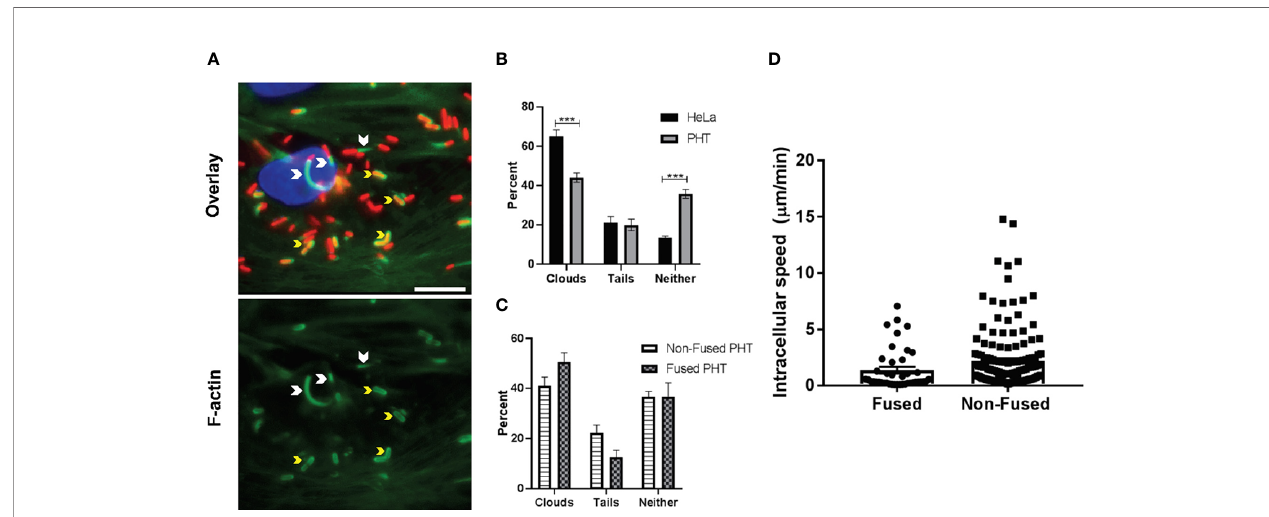
FIGURE 4 | Measure of F-actin clouds and comet tails. PHT and HeLa cells were infected with p actA -RFP L. monocytogenes for a total of 5 h (MOI 1). Cells were fi xed and labeled with DAPI, phalloidin-Alexa Fluor 488, and anti-E-cadherin antibodies conjugated to Alexa Fluor 647 (PHT only). Fluorescence images were acquired with the 100X objective and analyzed for the presence of F-actin comet tails and clouds. (A) Representative images, arrowheads point out F-actin tails and yellow arrows depict F-actin clouds. Scale bar = 50 µm. (B, C) At least 190 bacteria were counted per experimental condition in each experiment. Data are presented as Average percentages ± SEM (n = 3 (3 placentas), each experiment performed in duplicate). Statistical signi fi cance was determined by two-way ANOVA, Holm-Sidak ’ s procedure was used for multiple comparison adjustment. ***P = 0.0003, P = 0.0002 (left to right). (D) Intracellular L. monocytogenes speed was determined by acquiring Z-stacks with the 100x objective every 5 sec for 5 min to measure bacterial motility. Bacteria were tracked through each plane of the Z-stack using the multi-line function of Metamorph. Each plane is considered 5 sec and the total µm/min was calculated based on the total length of each bacterial track through the